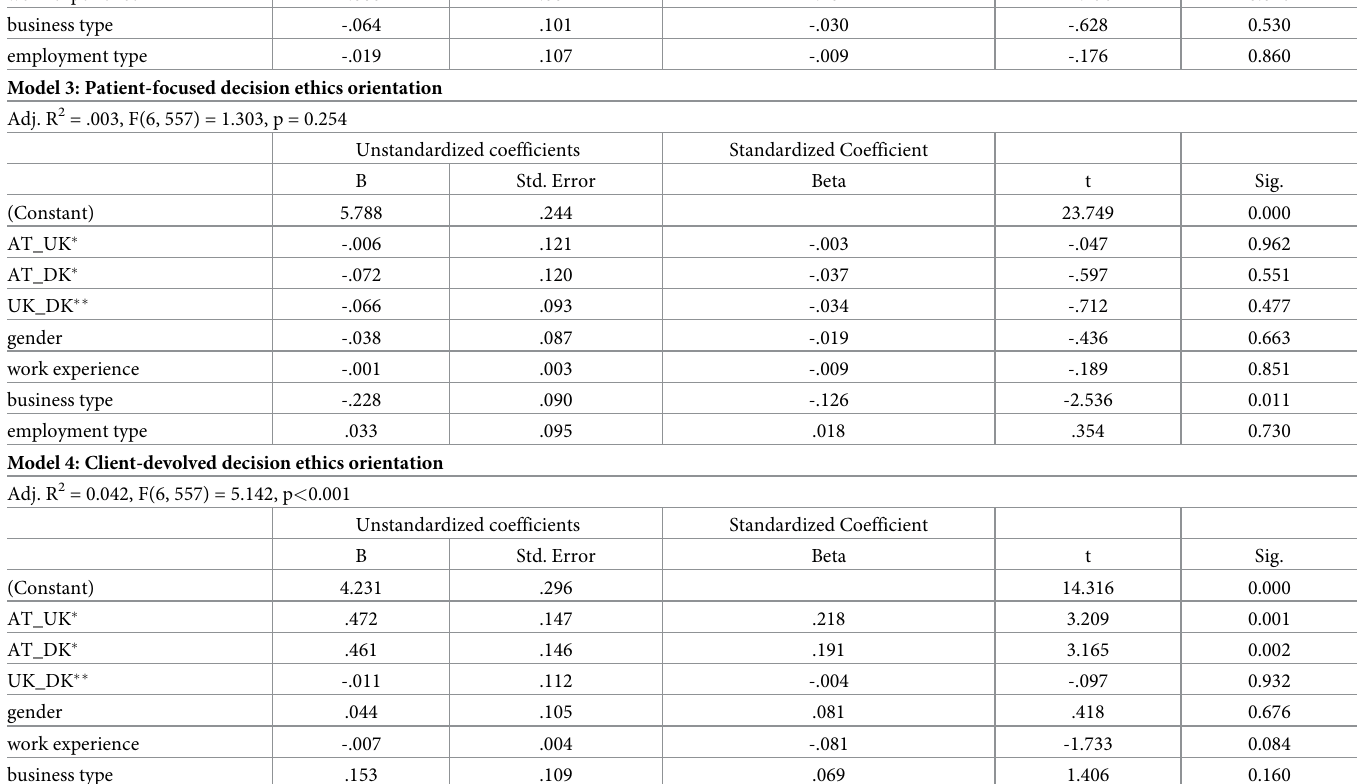
Model 3: Patient-focused decision ethics orientation